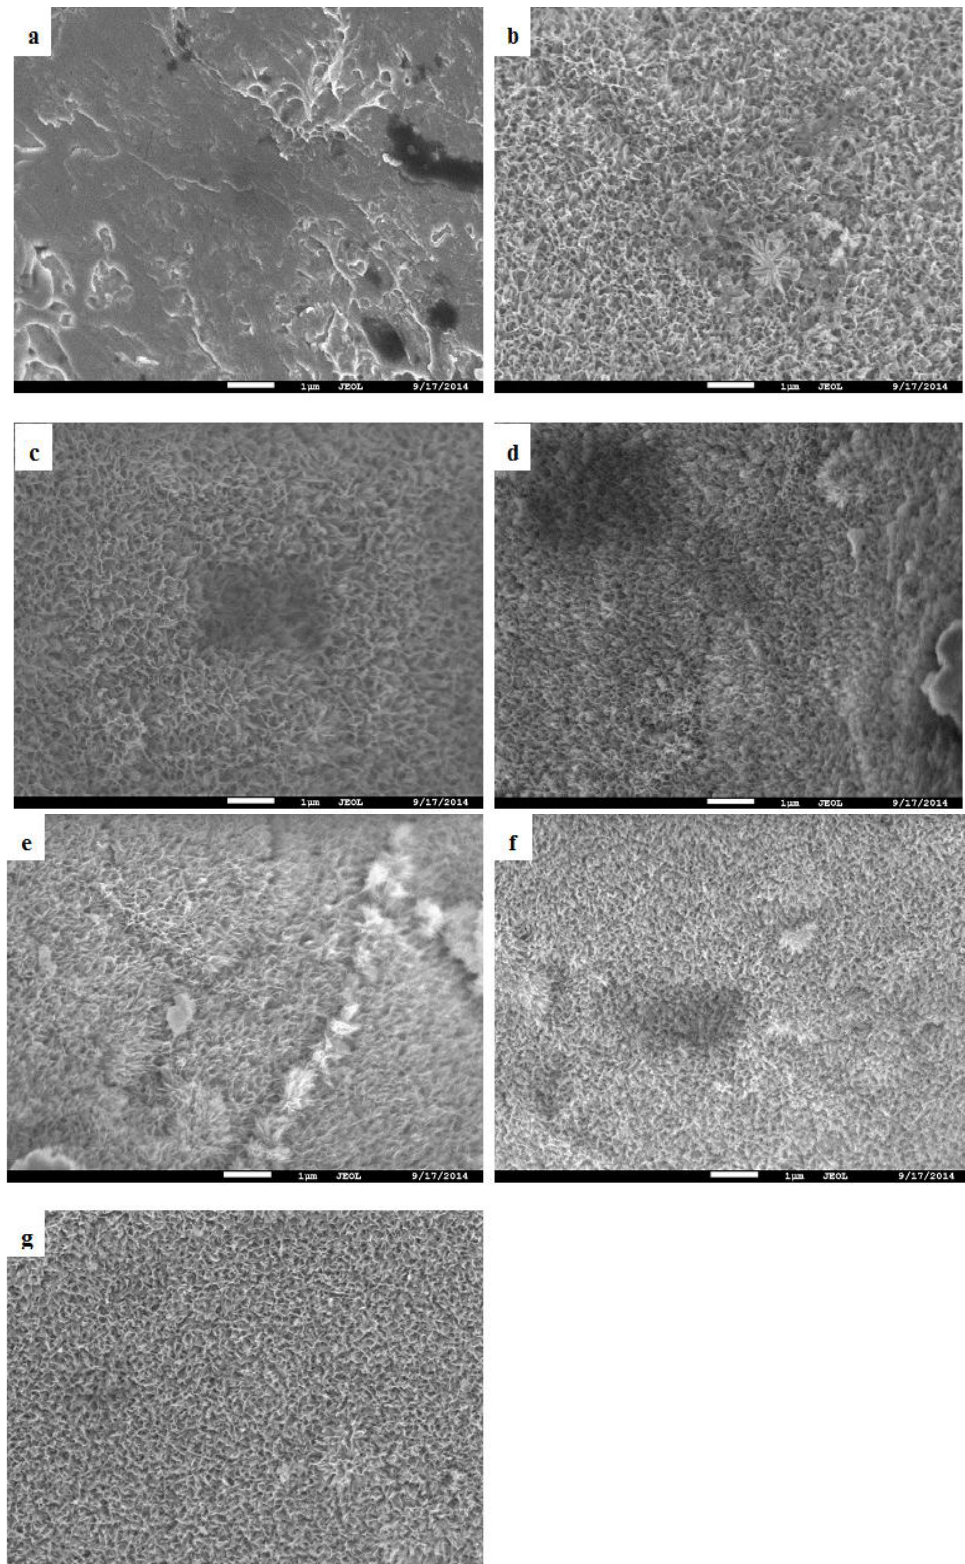
Figure 3. SEM micrographs after 3 week SBF immersion for ( a ) AsM and AlAcH treated samples for alkali treatment ( b ) 3M, 6 h ( c ) 3M, 24 h ( d ) 5M, 6 h ( e ) 5M, 24 h ( f ) 10M, 6 h and ( g ) 10M, 24